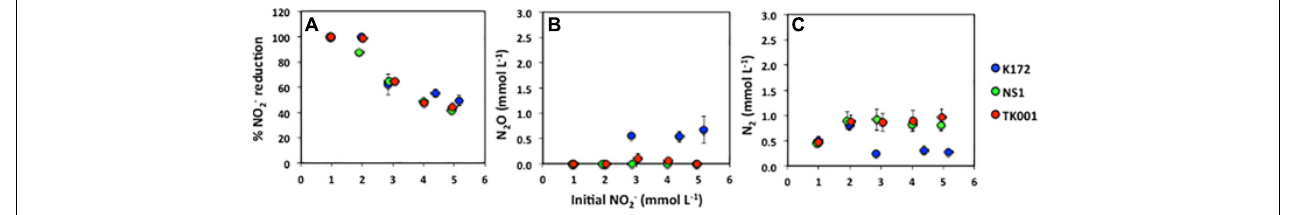
FIGURE 3 | (A) Percent NO 2 − reduction (Equation 2), and final concentrations of (B) N 2 O and (C) N 2 produced after 30 days of incubation in batch cultures of Thauera strains, shown as a function of varying initial NO 2 − concentrations ( ∼ 1 to 5 mmol L − 1 ; x -axis). Error bars represent standard errors for three to four replicates. The time series for these batches are shown in Supplementary Figure 4 .